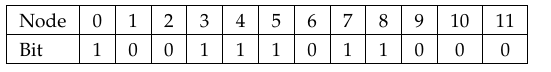
Figure 6. A T bitmap with the first node labeled as 0.